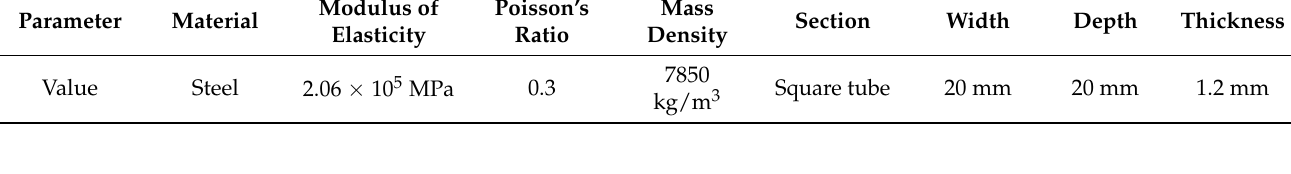
Table 1. Geometric and material properties.